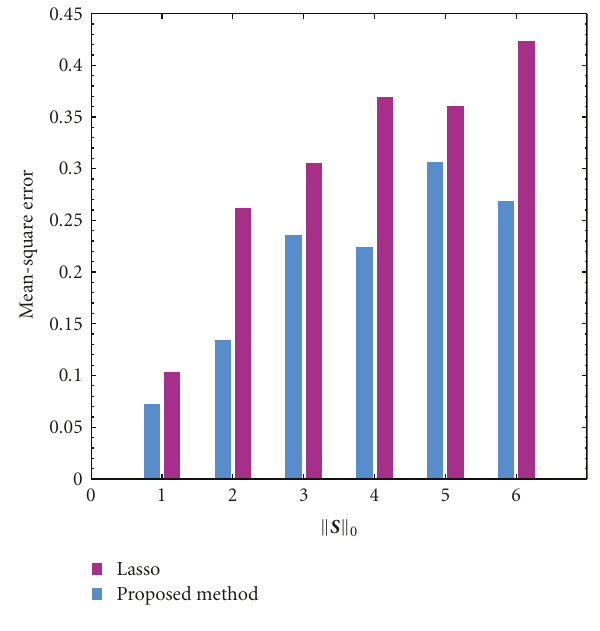
Figure 1: The histograms of h for the purposes of sparsity pattern recovery and approximation recovery (square-solid curves: the histogram of tuning parameter h for approximation recovery (AR), circinate-dash curves: the histogram of tuning parameter h for sparsity pattern recovery (SPR)).